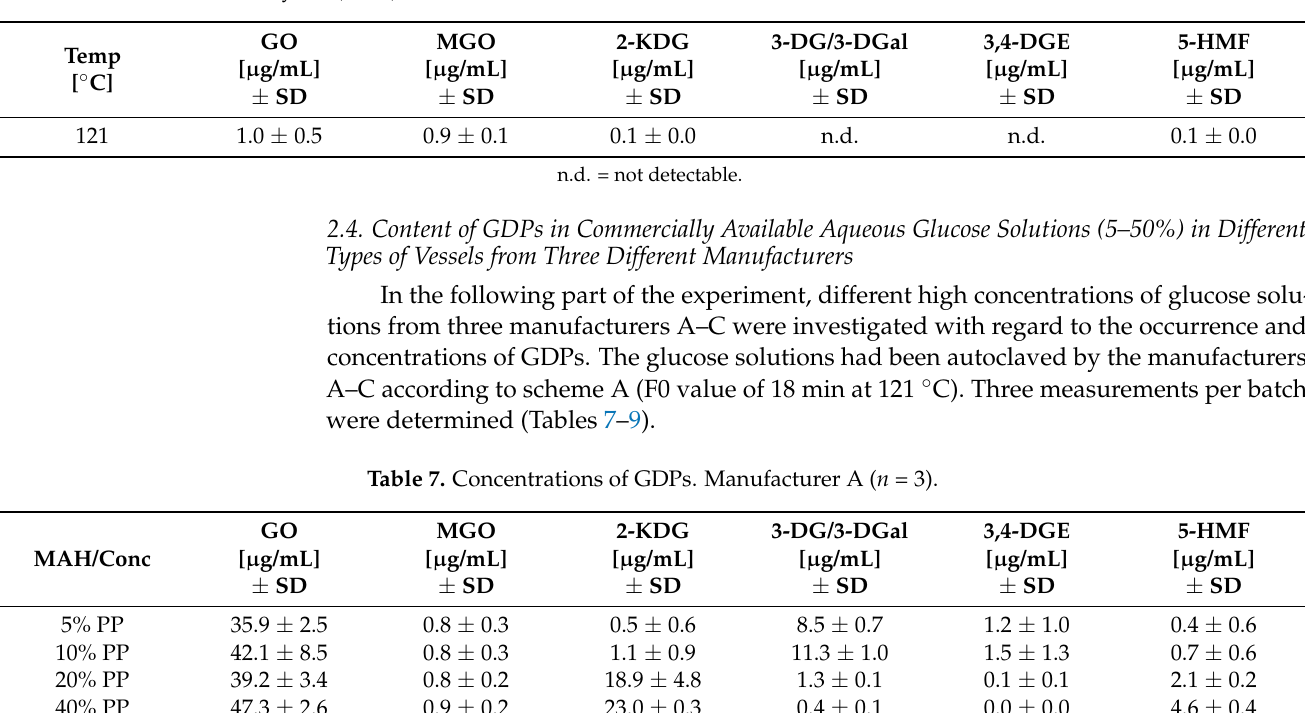
Table 6. Concentrations of GDPs in 10% ( w / v ) glucose solutions in PP bottles that were not heat sterilized (reference value). Three bottles were analyzed ( n = 3).